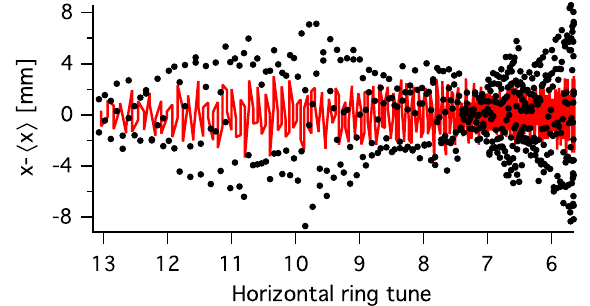
FIG. 5. Simulated accelerated orbit distortion versus tune before (black dots) and after (red line) COD correction of harmonics 6 – 13. The error sources and correction are as described for Fig. 3.